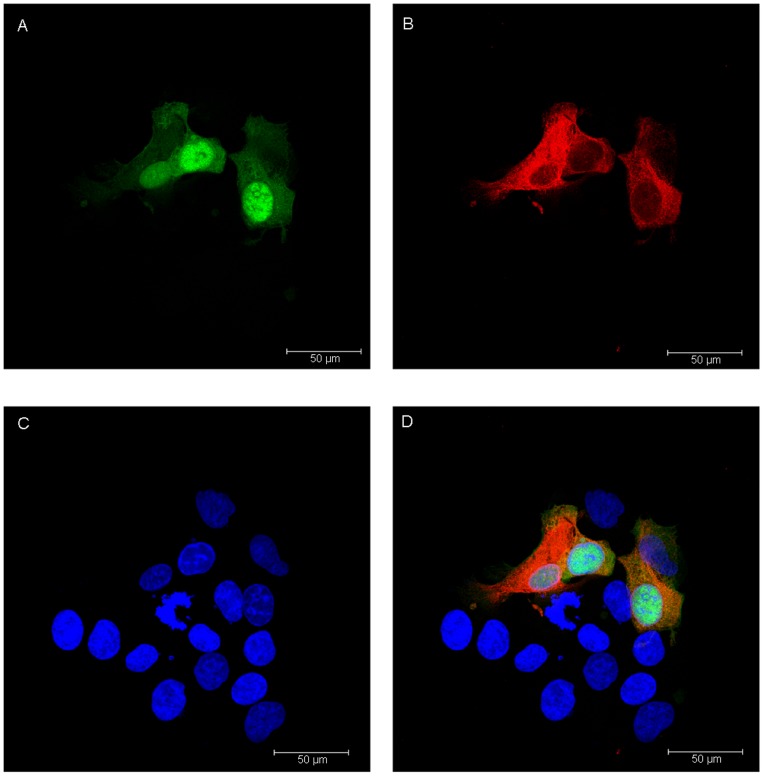
Fluorescent images of HT-29 cells infected with Ad-hITF.The hITF was detected using mouse anti-hITF antibodies and goat anti-mouse TRITC-labeled secondary antibodies. Nuclei were stained with DAPI. A, GFP; B, hITF; C, cell nuclei; D, merged images.